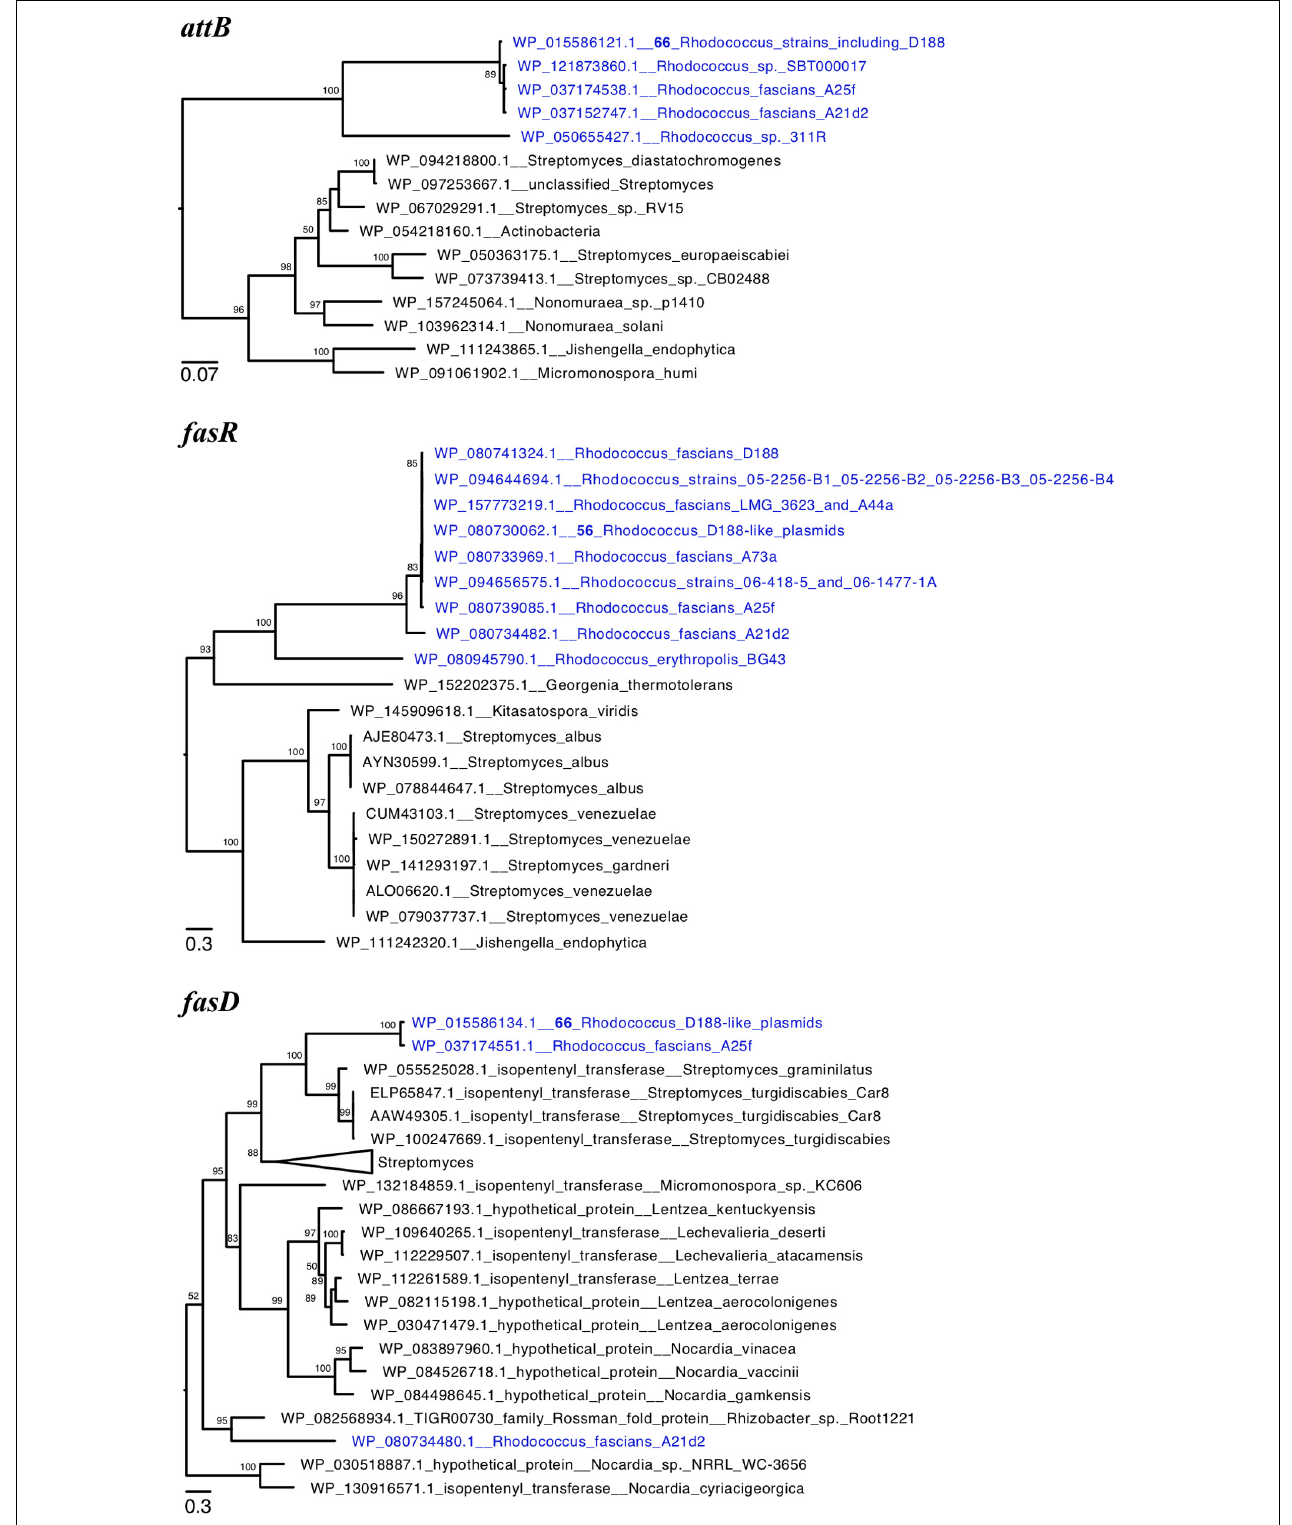
FIGURE 4 | Phylogeny of virulence genes of plant pathogenic Rhodococcus . Maximum likelihood phylogenetic trees of translated sequences of (A) attB, (B) fasR, and (C) fasD. The trees were midpoint rooted and a subset of clades of Rhodococcus virulence proteins are shown. Tips with identical sequences are indicated. Large clades were collapsed and labeled. Bootstrap values greater than 50 are shown.